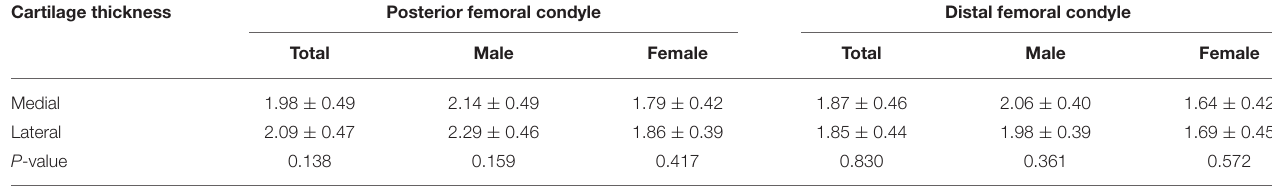
TABLE 2 | Cartilage thickness (mm). Cartilage